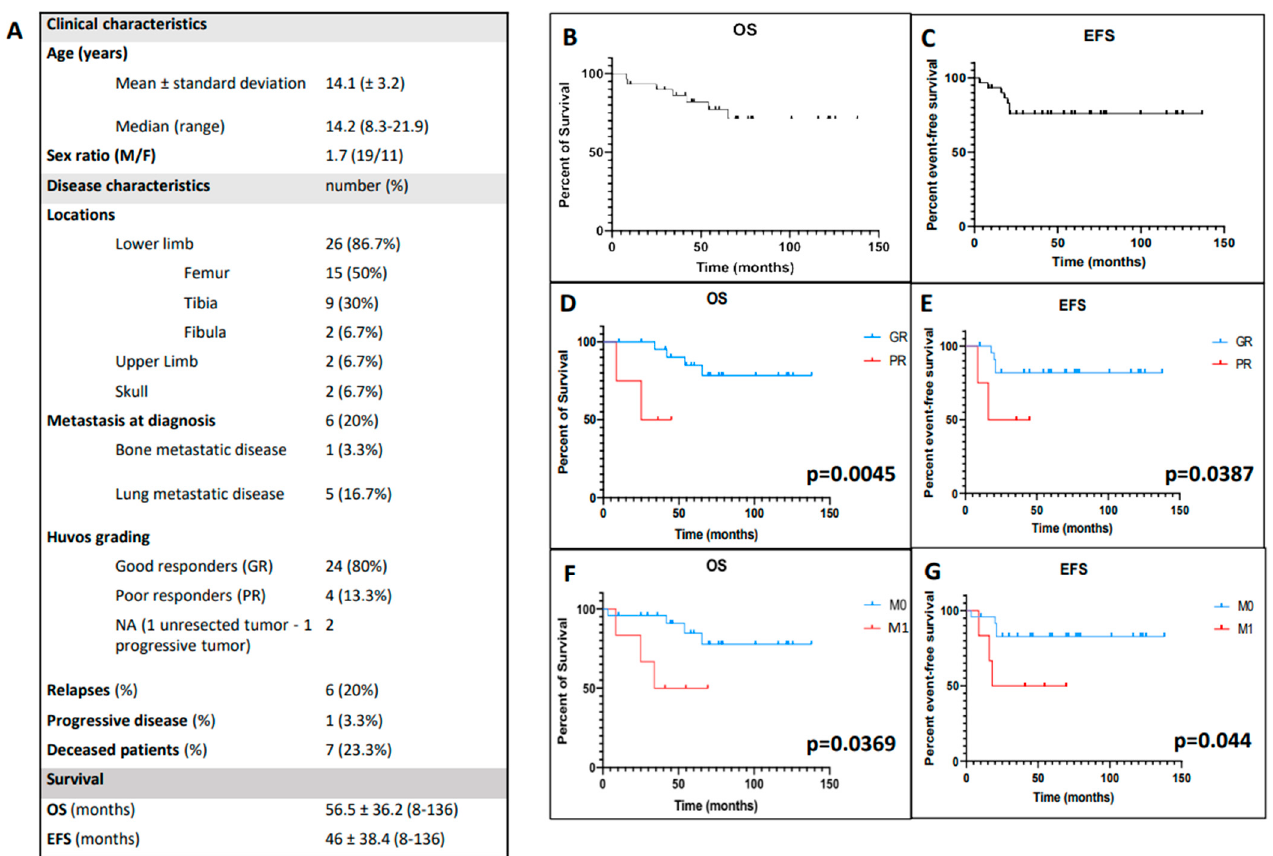
Figure 1. Summary of clinical and survival characteristics in our 30-patient cohort. ( A ) Table of all clinical features. ( B , C ) Kaplan–Meier curves reporting overall survival (OS) and event-free survival (EFS) in the cohort. ( D – G ) Kaplan–Meier significant correlations with clinical characteristics ( C – F ). The listed clinical characteristics are histological responses after chemotherapy (PR = poor responders, GR = good responders) and metastatic status at diagnosis (M0 = localized disease without metastasis, M1 = metastatic disease). p values are reported on the right corner of graphs and are significant when p < 0.05.